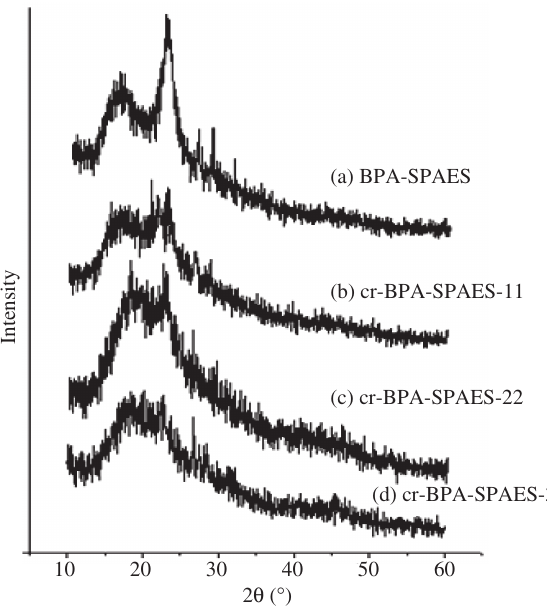
Figure 8: XRD graphs of BPA-SPAES and its crosslinked cr-BPA- SPAES